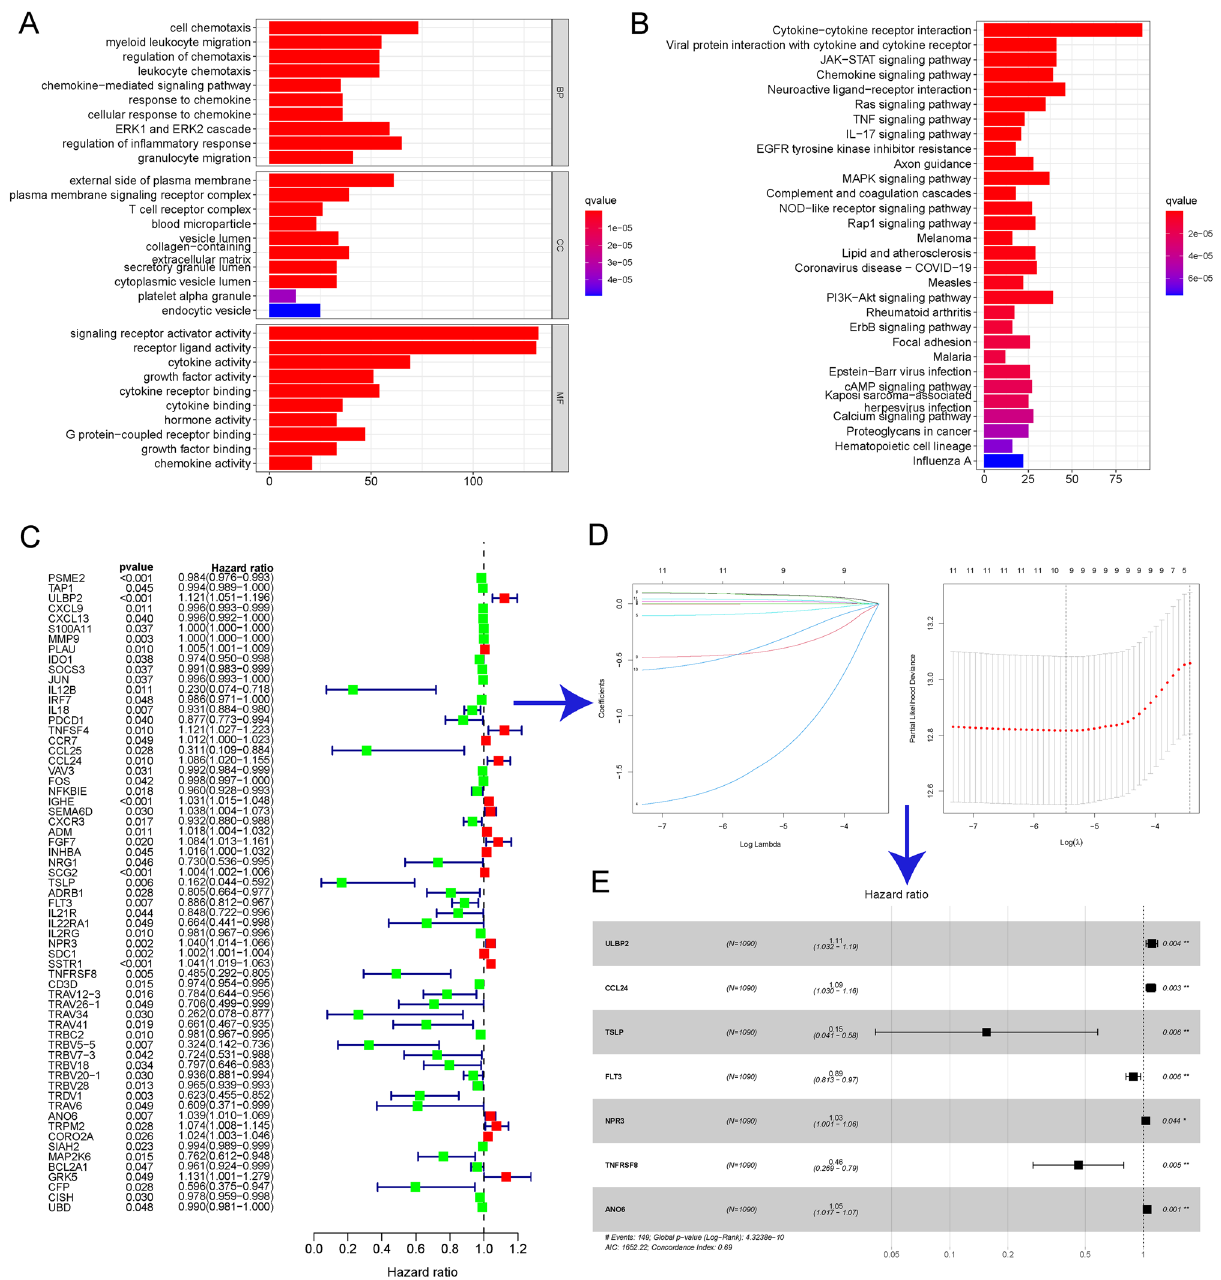
Figure 1. Characteristics of immune-related genes (IRGs) and construction of the IRG-related risk model in breast cancer (BC). ( A ) Gene Ontology (GO) enrichment analysis of IRGs. ( B ) Kyoto Encyclopedia of Genes and Genomes (KEGG) enrichment analysis of IRGs. The permission was obtained from the website: www. kegg. jp/ feedb ack/ copyr ight. html. Univariate Cox regression analysis ( C ), least absolute shrinkage and selection operator (LASSO) regression analysis ( D ), and multivariate Cox regression analysis ( E ) were applied to identify the prognostic IRGs. *P < 0.05; **P < 0.01; ***P < 0.001. IRG immune-related gene, BC breast cancer, GO Gene Ontology, KEGG Kyoto Encyclopedia of Genes and Genomes, LASSO least absolute shrinkage and selection